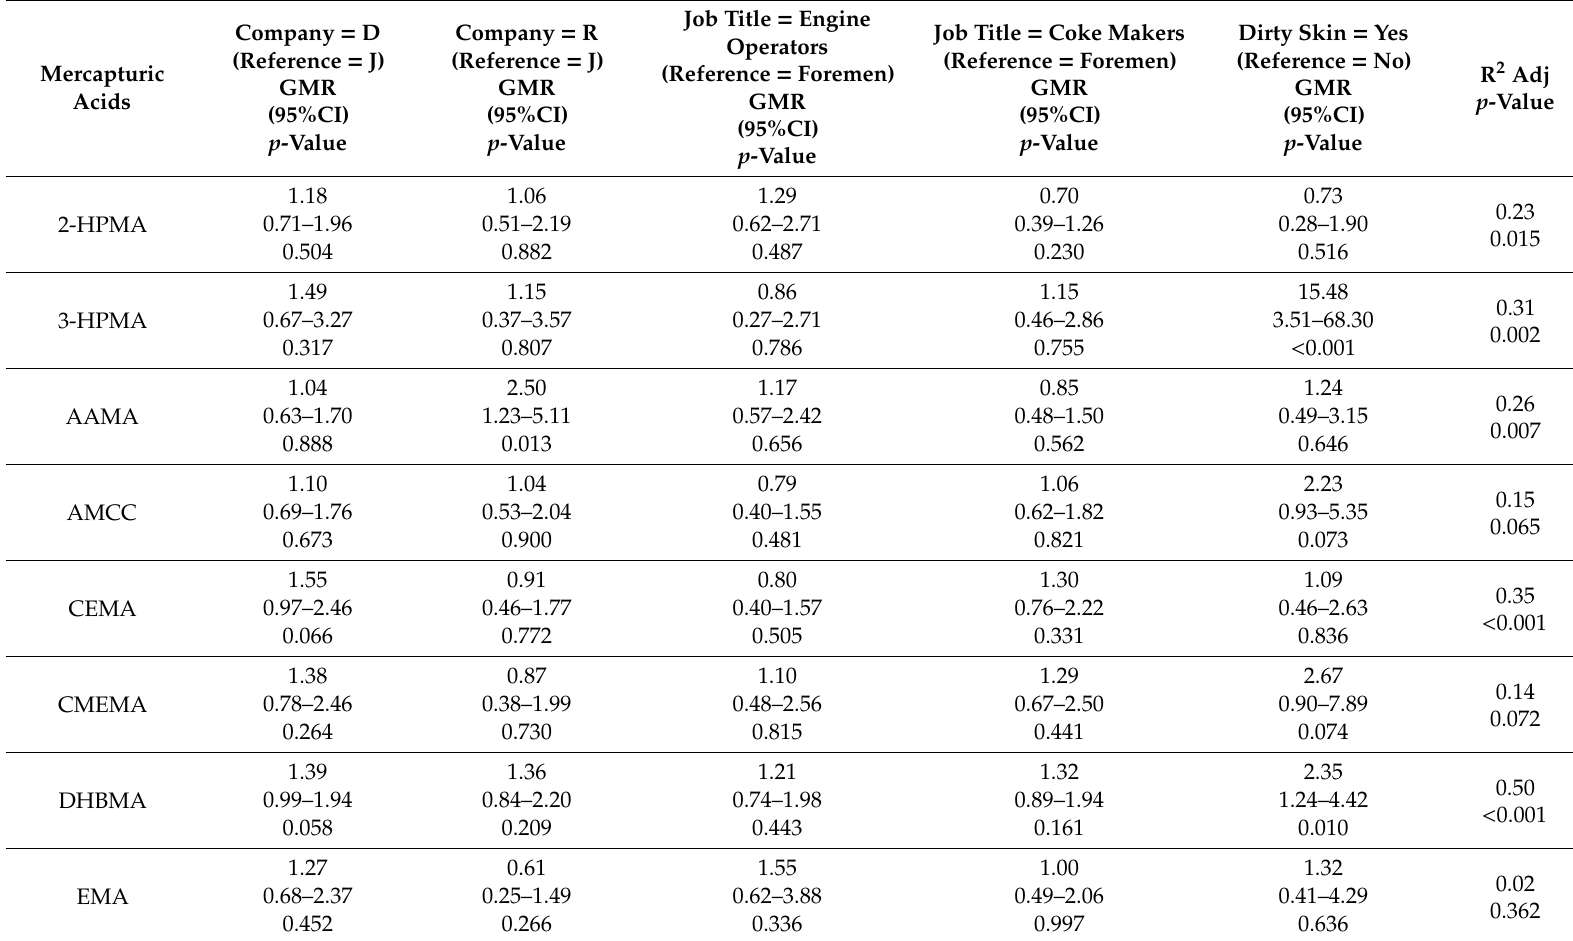
Table 4. Results of the linear models built to evaluate the di ff erences in levels of considered analytes among workers. The dependent variable of each linear model was the log 10 -transformed value of a mercapturic acid ( µ g / L). The independent variables were: plant (J = reference, D, or R), job title (foremen = reference, engine operators, or coke markers), dirty skin (no or yes), age (years), log 10 creatinine (g / L), and log 10 cotinine ( µ g / L) ( n =